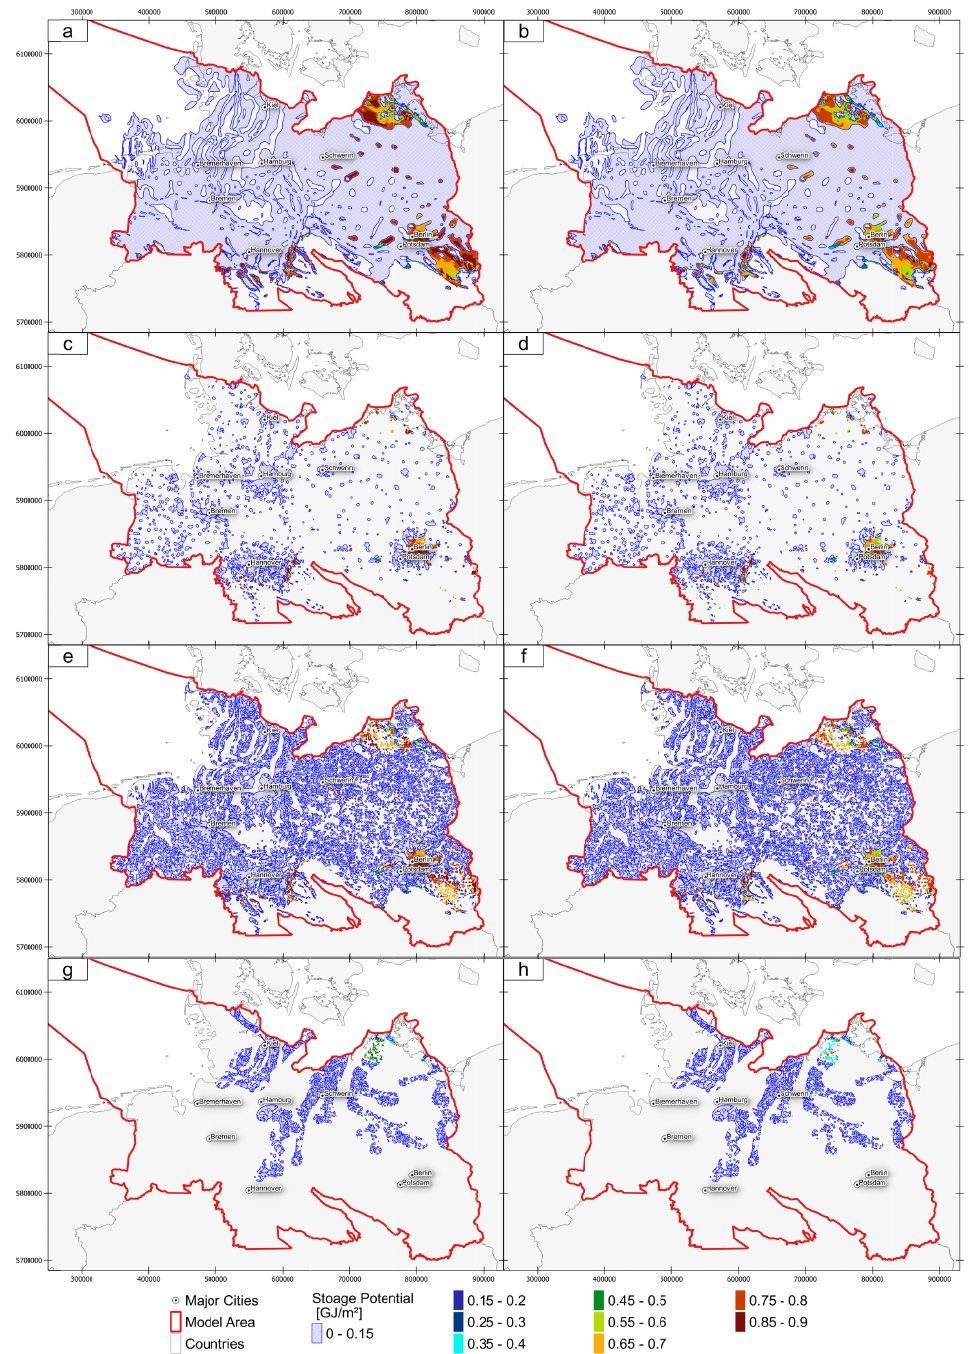
Figure 6. Calculated heat storage potential ( HSP ) for the Upper Keuper and Upper Exter Formation: ( a ) HSP with CEBS temperature data [32]; ( b ) HSP with GeotIS temperature data [46]; ( a , b ) Blank areas = reservoir not present; ( c ) HSP of the Upper Keuper in densely populated areas after ( a ); ( d ) HSP of the Upper Keuper in densely populated areas after ( b ); ( e ) HSP of the Upper Keuper in areas of high heating demand after ( a ); ( f ) HSP of the Upper Keuper in areas of high heating demand after ( b ); ( g ) HSP of the Upper Exter in areas of high heating demand with CEBS temperature data [32]; ( h ) HSP of the Upper Exter in areas of high heating demand with GeotIS temperature data [46]; ( a – f ) Color-coding and symbology indicated at the bottom. Coordinates are in UTM Zone